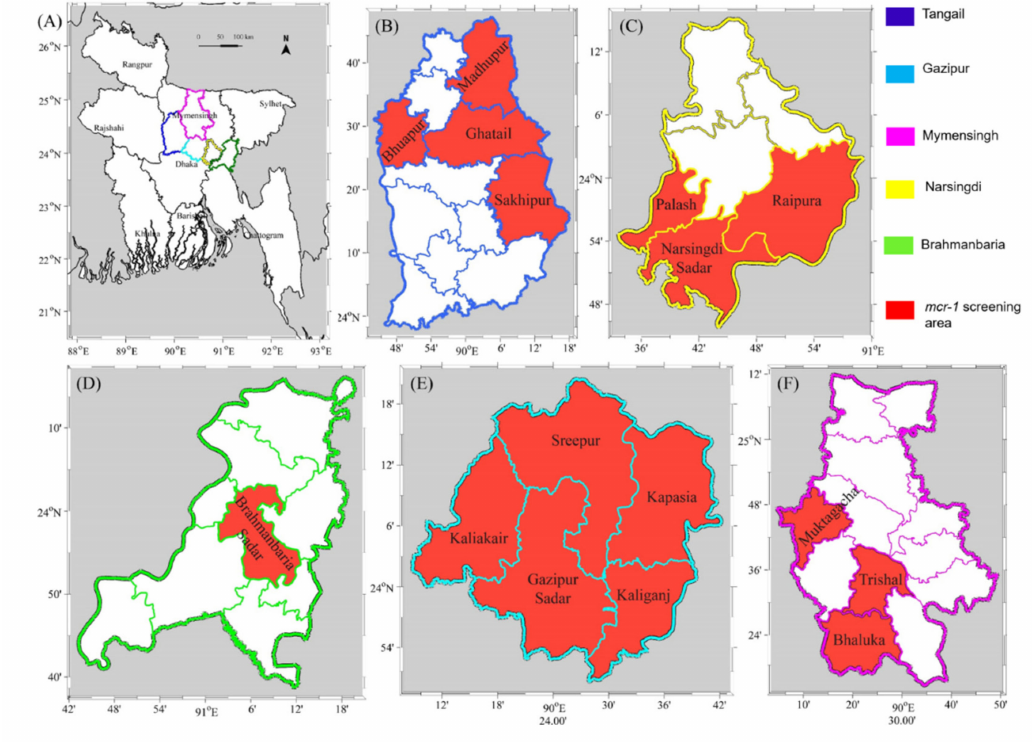
Figure 1. Geographical map of ( A ) Bangladesh showing Mymensingh division and the districts ( B ) Tangail ( C ) Narsingdi ( D ) Brahmanbaria ( E ) Gazipur and ( F ) Mymensingh of the sampling areas in the present study. Sampling areas where the mcr-1 gene was screened are highlighted in